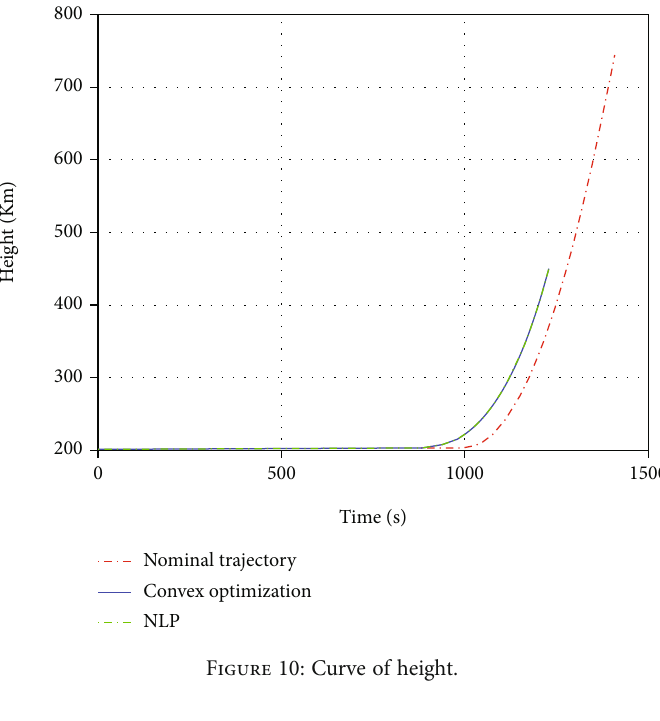
Figure 10: Curve of height.